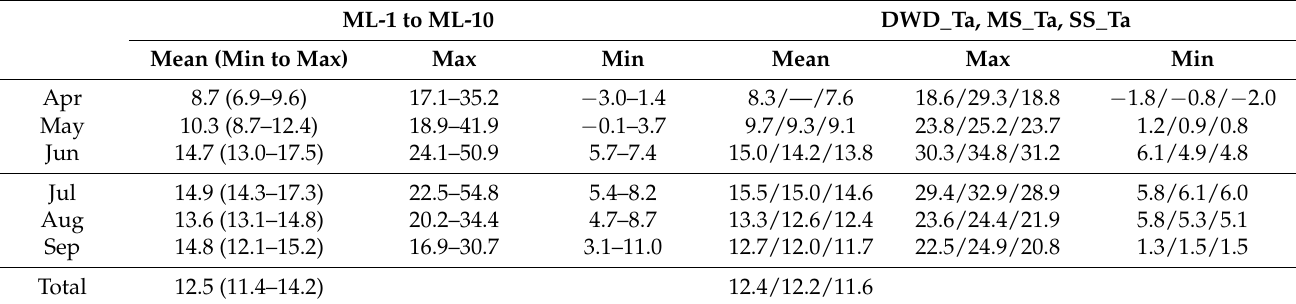
Table 3. Descriptive statistics of hourly temperature data measured near the soil surface at the Micro-Loggers (ML-1 to ML.-10), and in the air at the nearby official weather station (DWD_ta, 2 m) and at two stations within the forest (MS/SS_Ta, 50